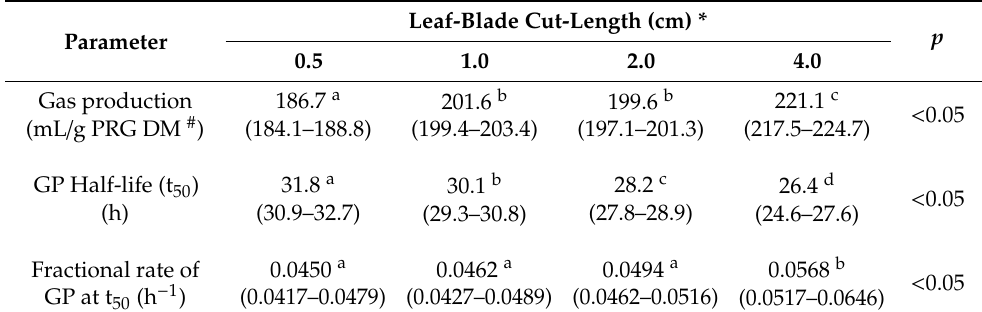
Figure 3. Effect of leaf-blade cut-length on cumulative gas production by N. frontalis fermentation of fresh perennial ryegrass (PRG). The plot is a representation of the fitted profiles generated using the model of France et al., [20]. Symbols represent mean net volumes for four replicated bottles with differing cut-lengths as identified in the figure. Time since grass addition is relative to the start of leaf-blade additions for each treatment. Table 1. Effect of fresh perennial ryegrass (PRG) leaf-blade cut-length on N. frontalis fitted total gas production (GP) data and derived parameters.